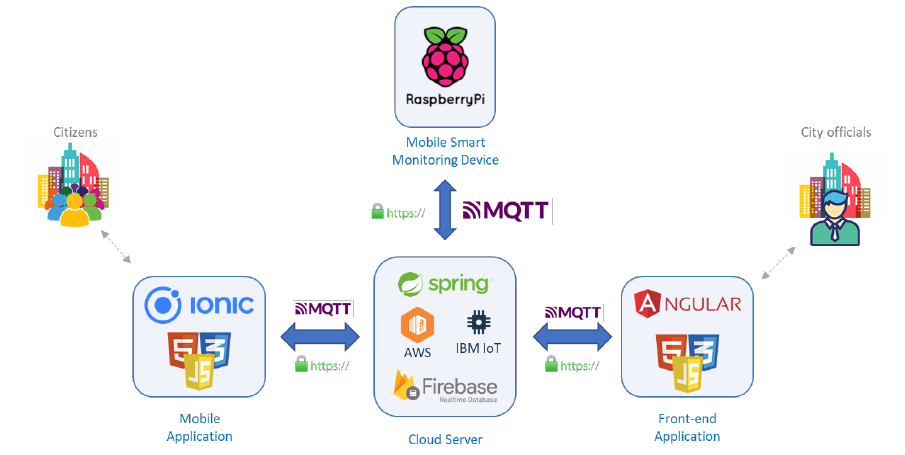
Figure 1. System architecture of the proposed